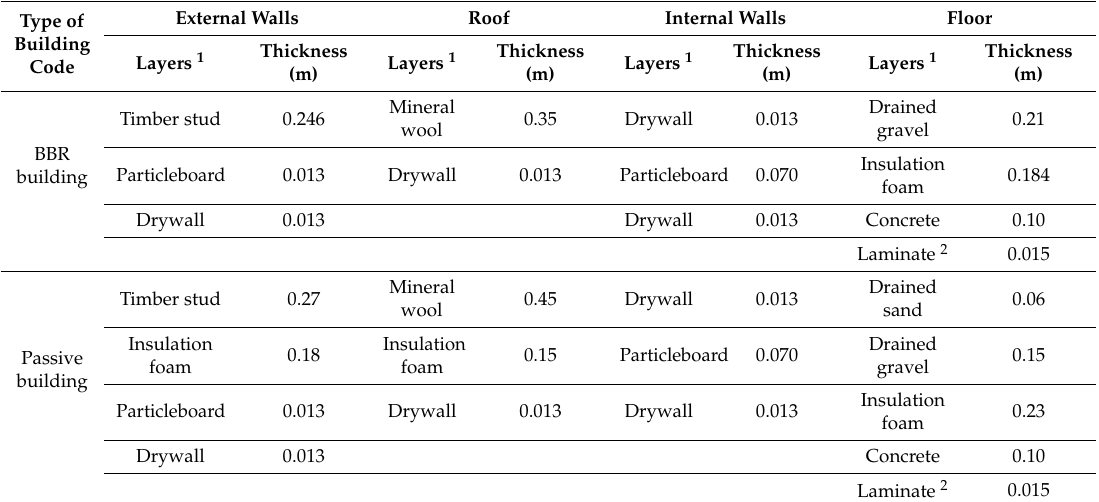
Table 3. The details of building construction components for both Swedish building regulation (BBR) and passive building criteria.